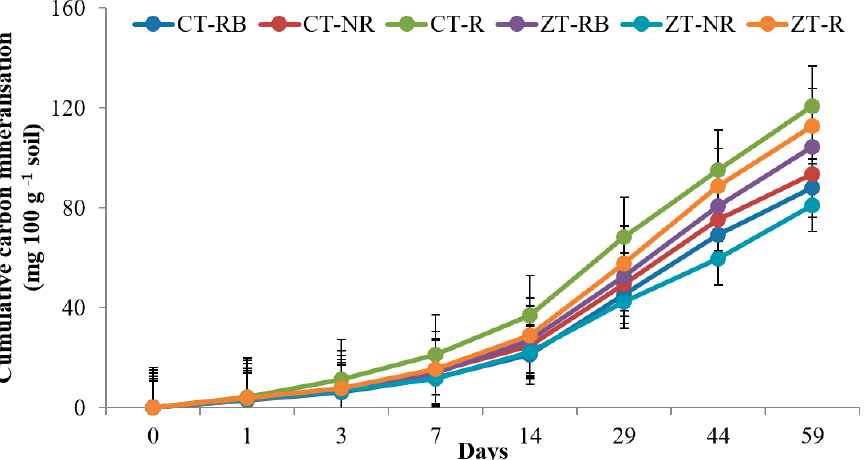
Figure 1. Cumulative carbon mineralization (mg 100 g − 1 soil) of bulk soil in 0–5 cm depths as affected by 18 years of tillage and residue management in a rice–wheat cropping system in an Inceptisol at 37 °C. ZT = zero tillage; CT = conventional tillage; NR = no residue; RB = residue burning; R = residue retention. Error bars identify LSD ( p ≤ 0.05) of different treatments.